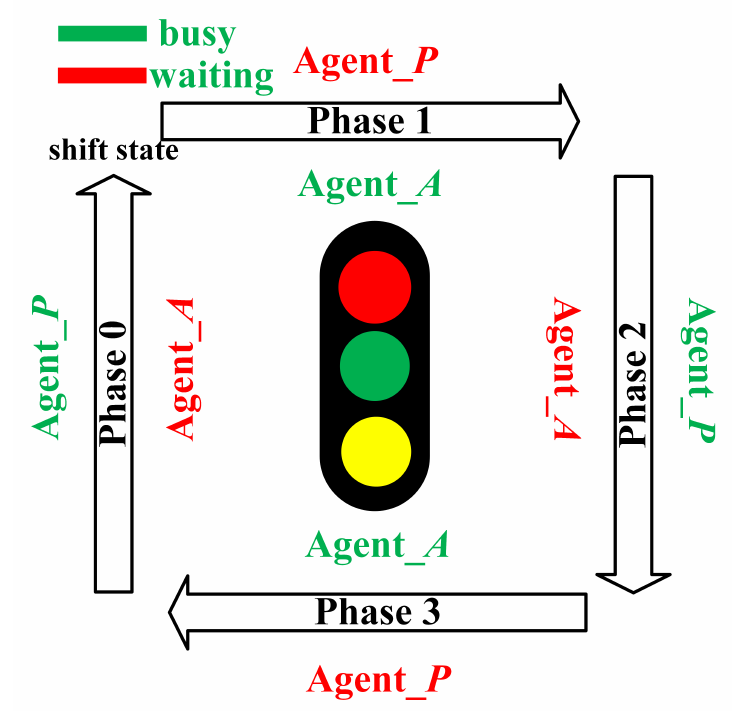
Figure 4. Operating mode to ensure the fixed phase sequence. The red and green color indicates waiting and busy state